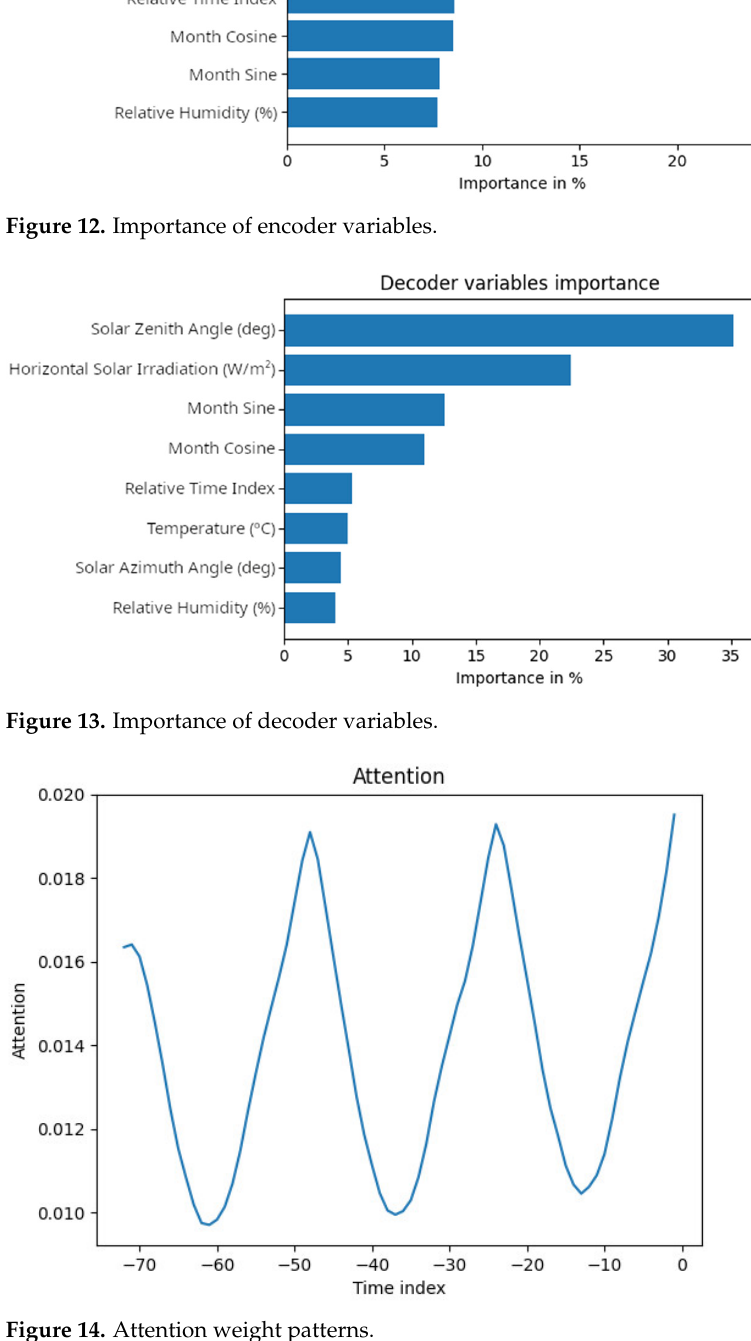
Figure 14. Attention weight patterns.